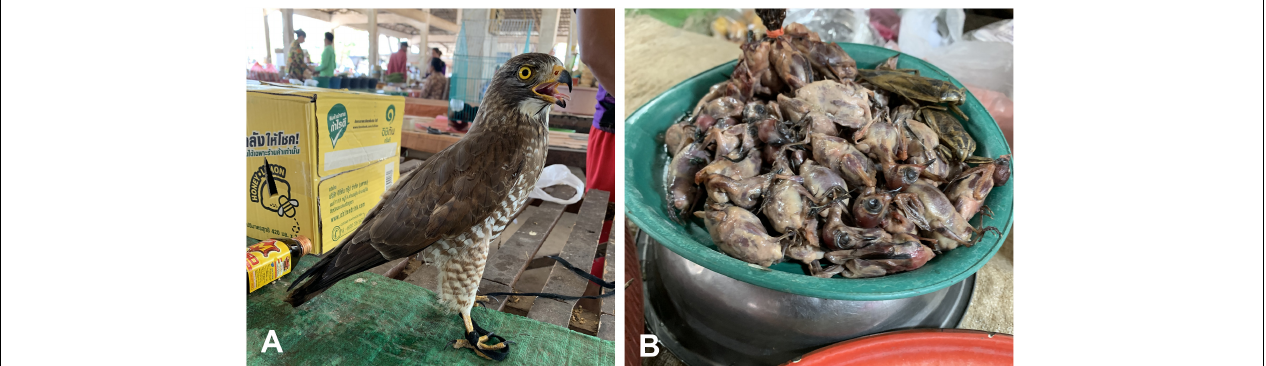
FIGURE 6 | Migratory landbirds are heavily hunted in Southeast Asia and parts of China for the pet trade, and for food. (A) Grey-faced buzzard Butastur indicus for sale at a pet shop, (B) various swallow species are caught in large numbers for human consumption in northern Laos (Image credits: Yong Ding Li).